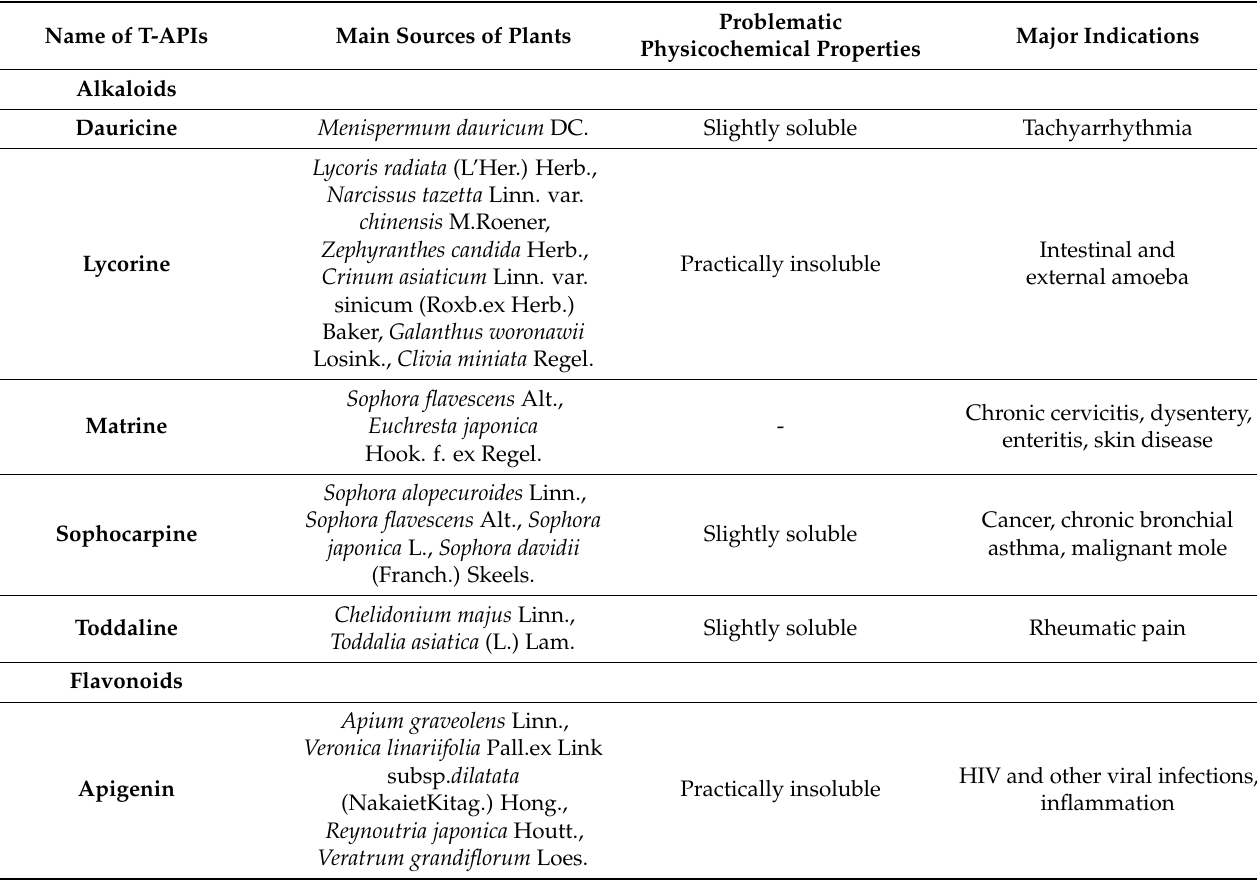
Table 1. The problematic physiochemical properties of some T-APIs as new potential drugs